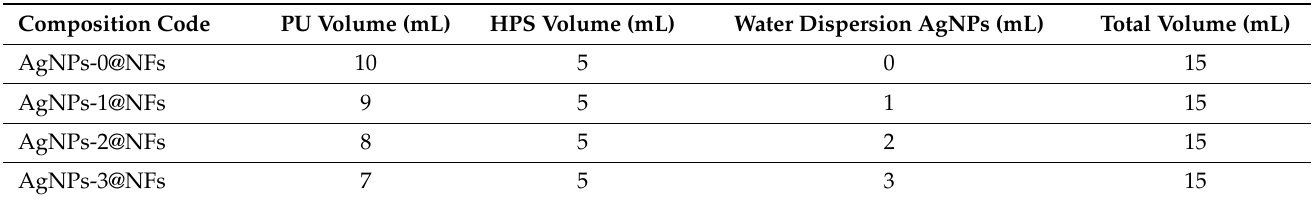
Table 1. The lists of the utilized volumes of polymers and AgNPs used in the preparation of electrospinning solutions (PU—polyurethane (12 wt.% solution in DMF), HPS—hydroxypropyl starch (15 wt.% solution in DMSO)).